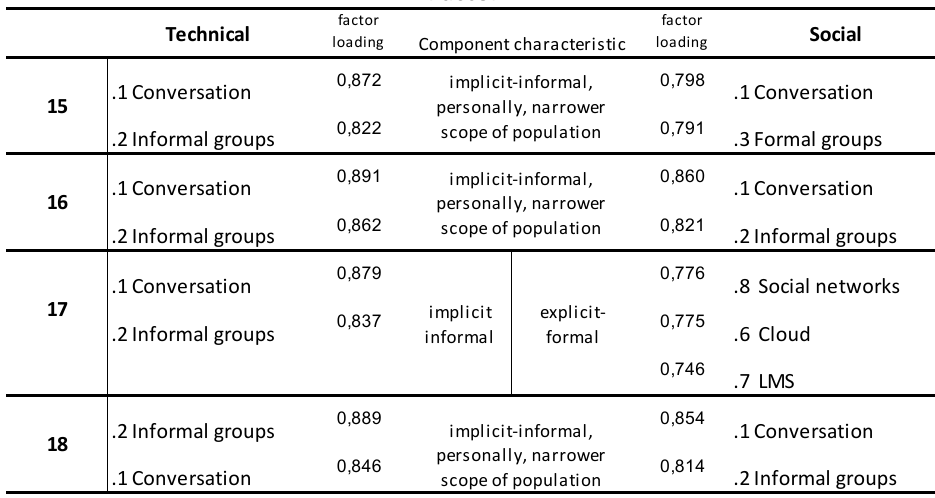
Figure 10. Areas and activities referred to by Factor two.